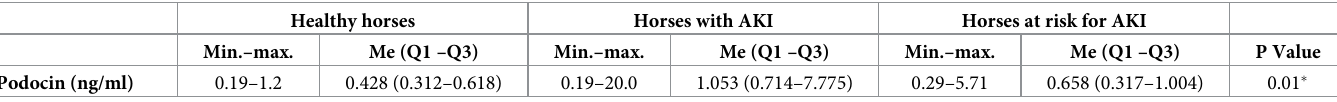
Table 3. Results of the podocin concentration based on the quantitative ELISA test in healthy horses, horses with clinical kidney dysfunction (horses with AKI) and horses at risk for acute kidney injury. Healthy horses Horses with AKI